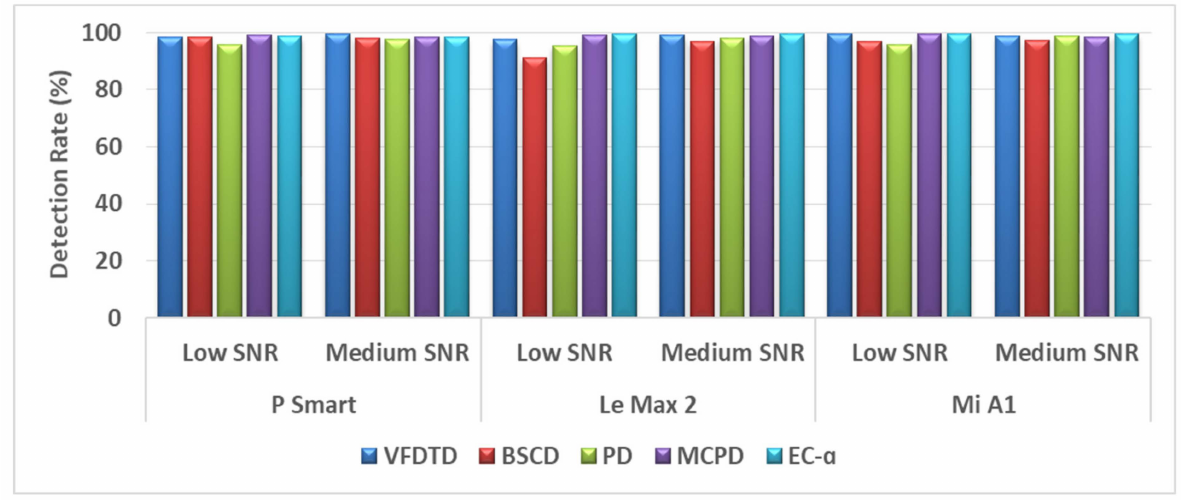
Figure 6. Transient starting point detection accuracy of the methods for Wi-Fi signals with sharp rising edge at low and medium